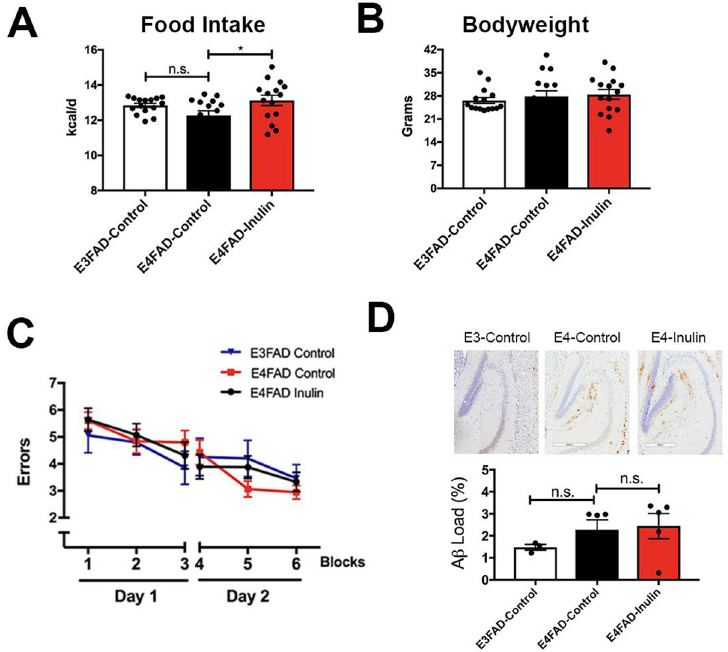
Fig 1. Effect of inulin on food intake, body weight, cognition and A β retention in E4 FAD mice. Inulin intake increased daily energy uptake (kcal/d) from the diet in the E4 FAD mice (A) but did not change bodyweight (B). (C) The mice showed no performance differences on the RAWM test. Wrong entries were recorded as errors. There were no significant differences in performance among E3 FAD-Control, E4 FAD-Control and E4 FAD-Inulin mice in any of the 6 blocks. (D) Representative images of A β immunohistochemical staining from the three groups of mice (Top) and quantitation of the A β load (Bottom). There were no significant differences in A β load among the three groups of mice. Data are presented as the mean ± SEM. n.s. = not significant; � p < 0.05.